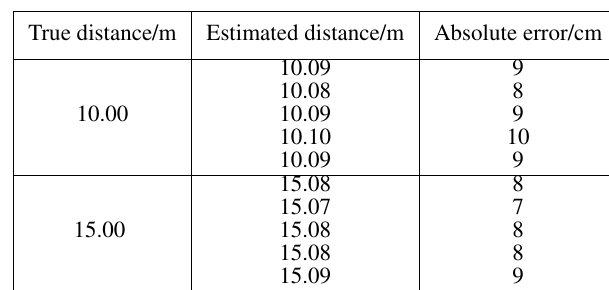
Table 2. Pool experiment ranging